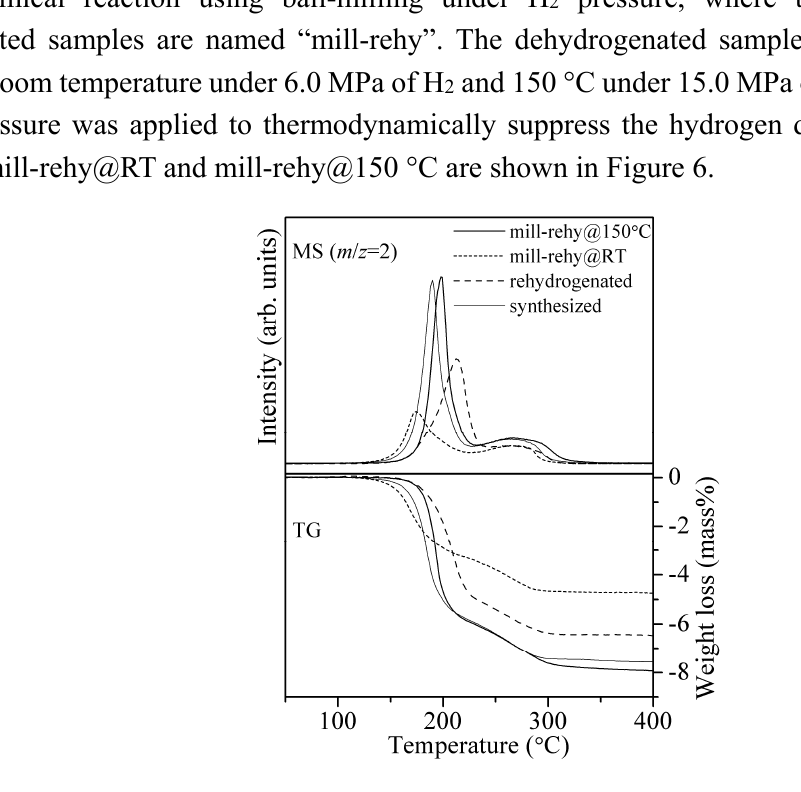
Figure 6. TG-MS profiles of the 8LiH-3Mg(NH 2 ) 2 samples after synthesis, thermochemical rehydrogenation, and mechanochemical rehydrogenation at room temperature and 150